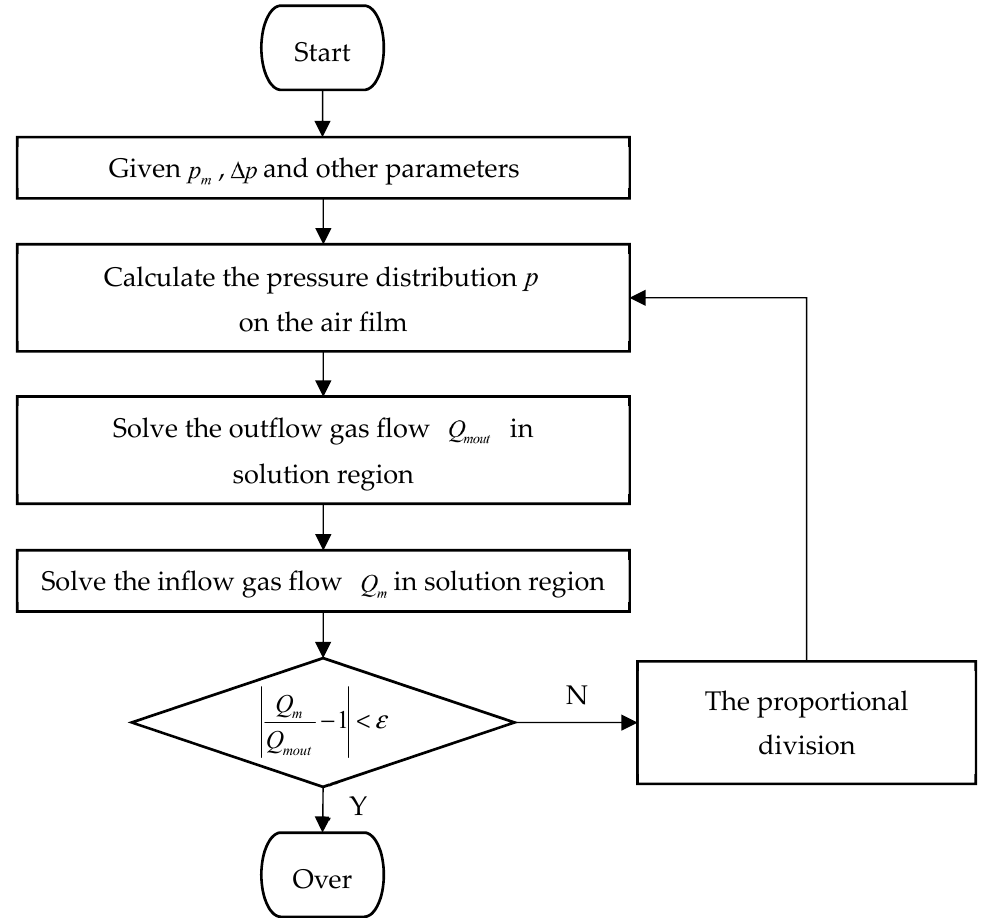
Figure 4. Flow chart of the calculation of governing equation.